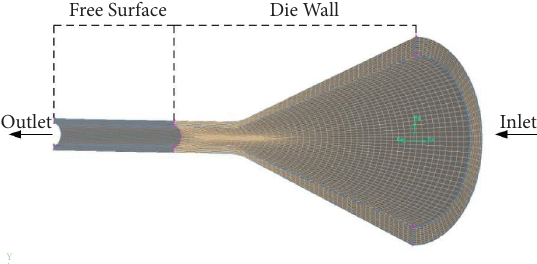
Figure 3: Finite element meshes used in the